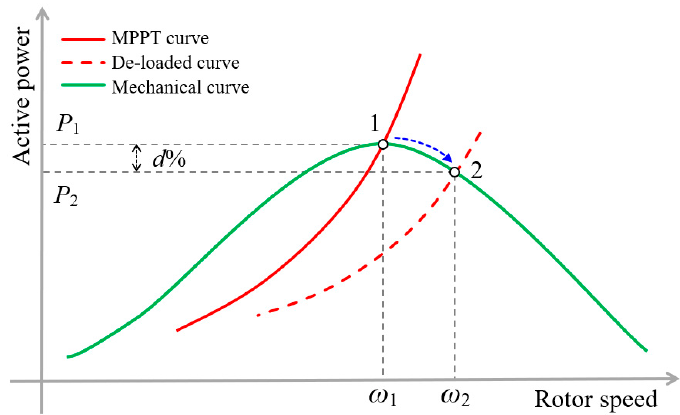
Figure 2. De-loaded operation by over-speeding strategy.